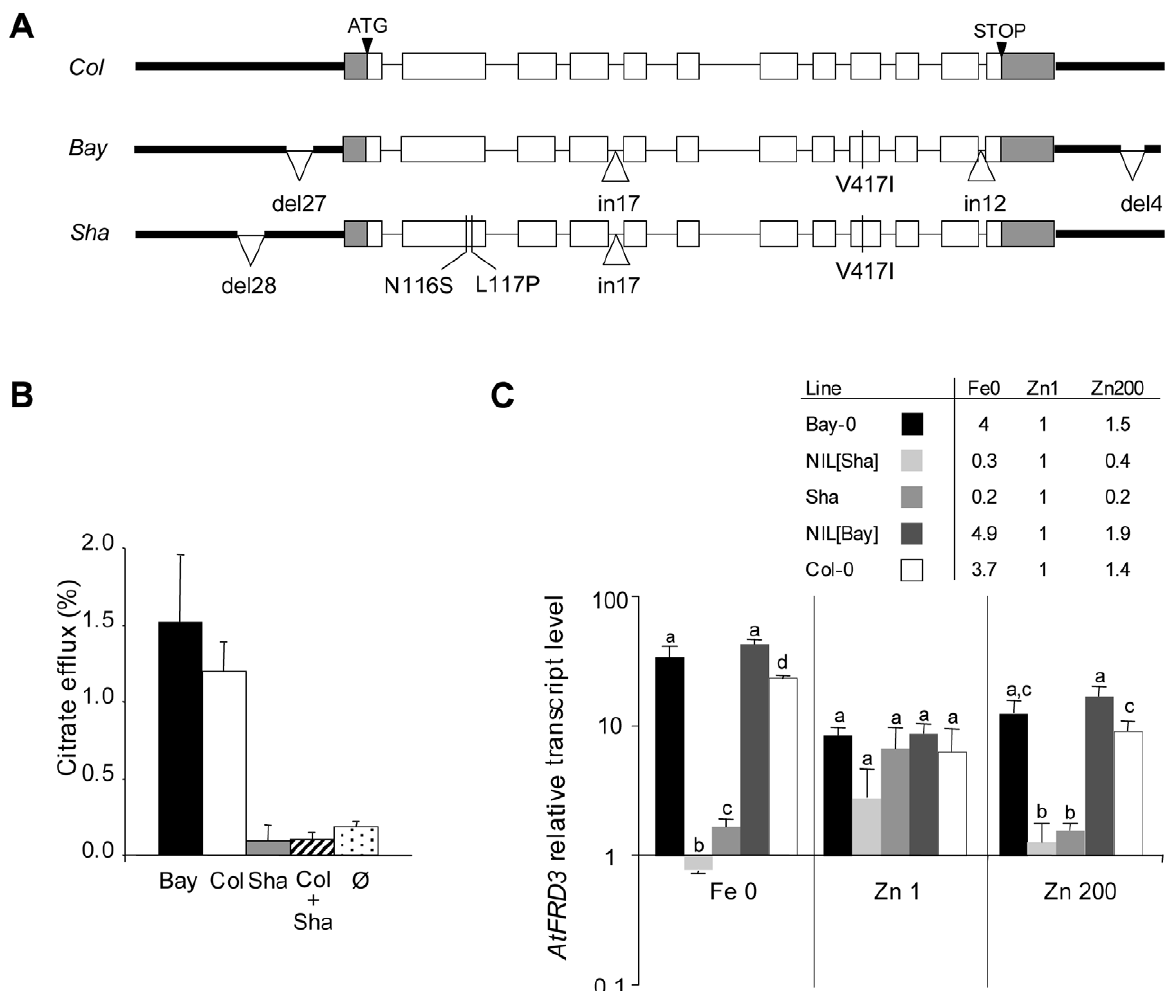
Figure 3. Natural variation in the FRD3 sequence, FRD3 transport activity, and FRD3 transcript accumulation. (A) Gene organization and allelic variations identified at the FRD3 locus in Col-0 (reference sequence), Bay-0 and Sha. In non-coding regions, only insertions and deletions are shown. In the coding region, synonymous SNPs are not indicated. (B) 13 [C]-citrate efflux activity resulting from the expression of FRD3 Bay (Bay), FRD3 Col (Col) and FRD3 Sha (Sha) proteins or the co-expression of FRD3 Sha and FRD3 Col (Col + Sha) in Xenopus oocytes. In control oocytes (Ø), no RNA was injected. Data are the means 6 S.D.M. for n=3 sets of 14 oocytes. (C) FRD3 transcript accumulation under Fe deficiency (Fe 0), control conditions (Zn 1) and excess Zn (Zn 200) in parental and NIL lines. FRD3 transcript levels are shown relative to the transcript level of ACT2/ACT8. Values represent the means 6 S.D.M. for n=3 biologically independent experiments. Different letters above bars indicate significantly different values within a treatment set (P , 0.05) according to a non-parametric test for Fe0, and Zn200 and a Tukey test for Zn1. The table indicates FRD3 transcript levels for the Fe0 and Zn200 conditions relative to those for the control Zn1 condition.